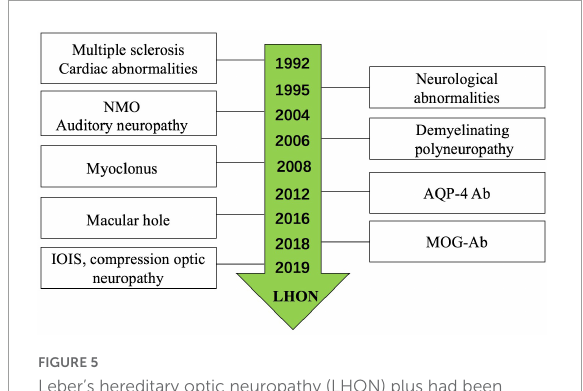
FIGURE5 Leber’s hereditary optic neuropathy (LHON) plus had been reported for